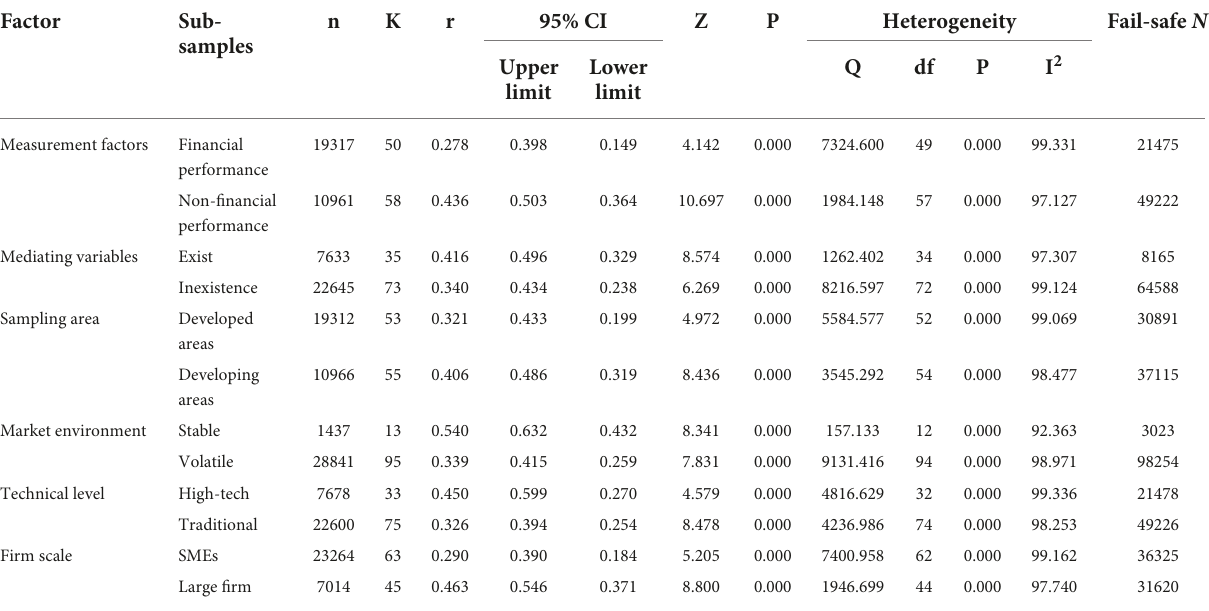
TABLE 3 Moderating effect